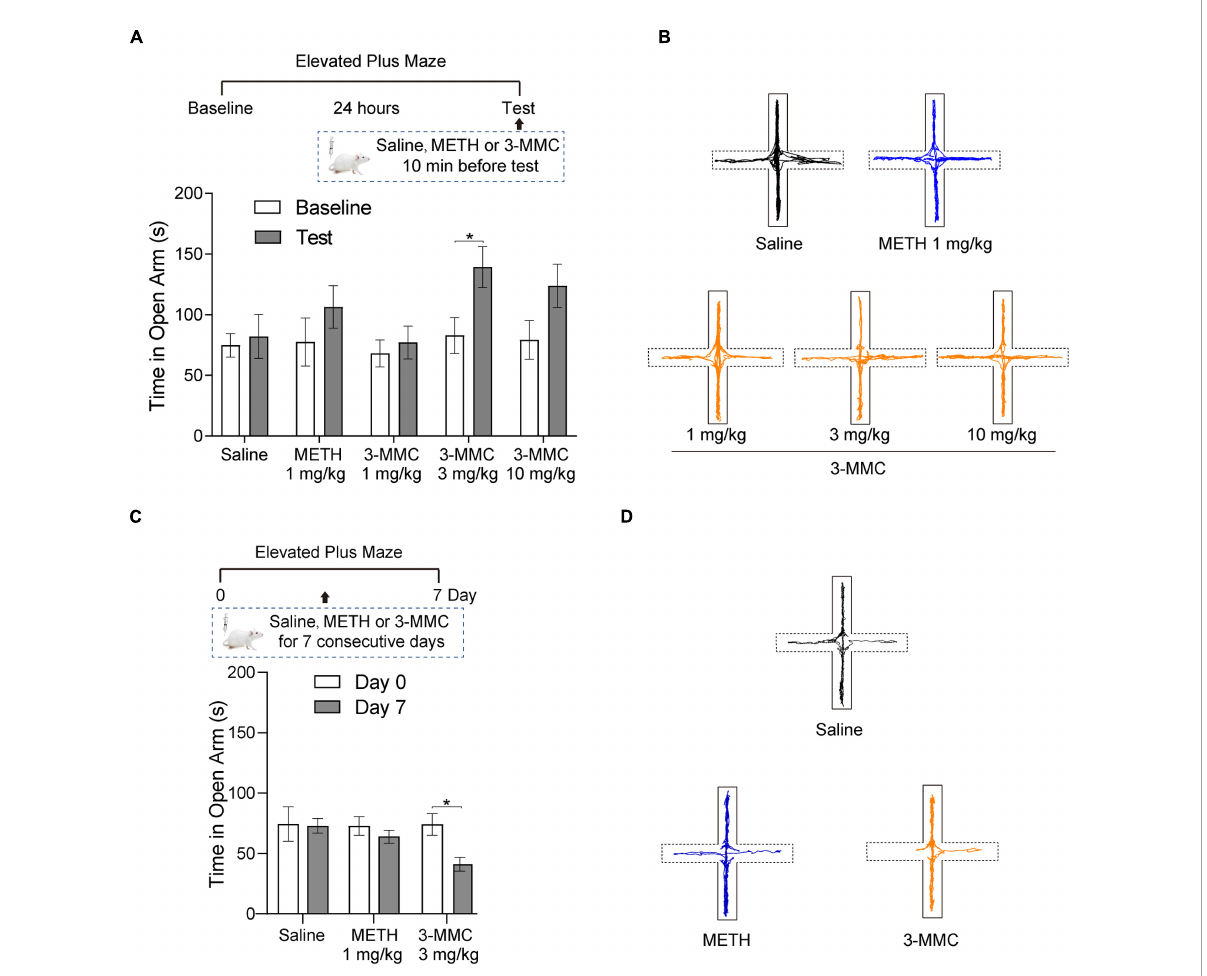
FIGURE2 The effects of acute and chronic injection of 3-MMC on EPM. (A) A single injection of 3-MMC (3 mg/kg) increased the time in open arms, paired t -test, * P < 0.05 significant differences for each drug in EPM test, n = 7 for each group. (B) Representative diagrams of travel trace in EPM after acute 3-MMC exposure. (C) 7 consecutive days of 3-MMC (3 mg/kg) injection decreased the time in open arms, paired t -test, * P < 0.05 significant differences for each drug in EPM test, n = 9 for each group. (D) Representative diagrams of travel trace in EPM after chronic 3-MMC exposure. Data are presented as mean values ±